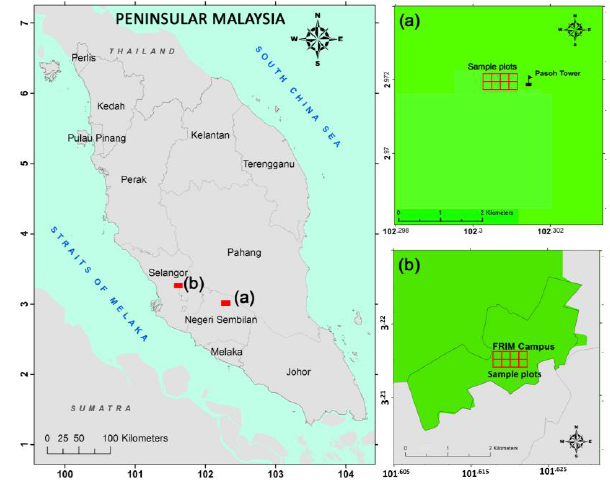
Figure 1. Location of the study area (Peninsular Malaysia) and sample plots; ( a ) Pasoh Forest Reserve (PFR) plot and, ( b ) Forest Research Institute Malaysia (FRIM) plot. The size of each rectangular plot was 0.5 ha (50 m × 100 m) and was subdivided into eight experimental subplots (25 m × 25 m). Adapted from